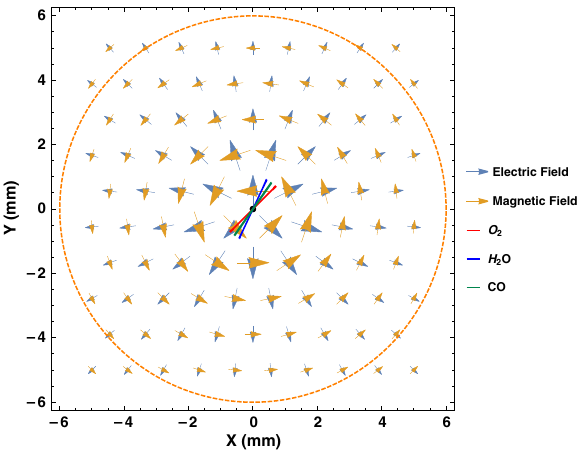
, th (bottom). th as a th . th